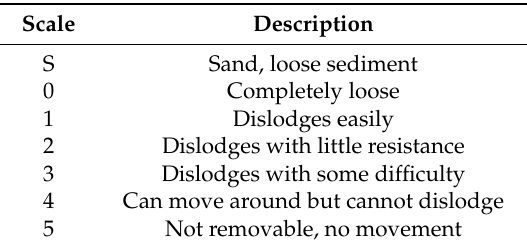
Table 1. Embeddedness